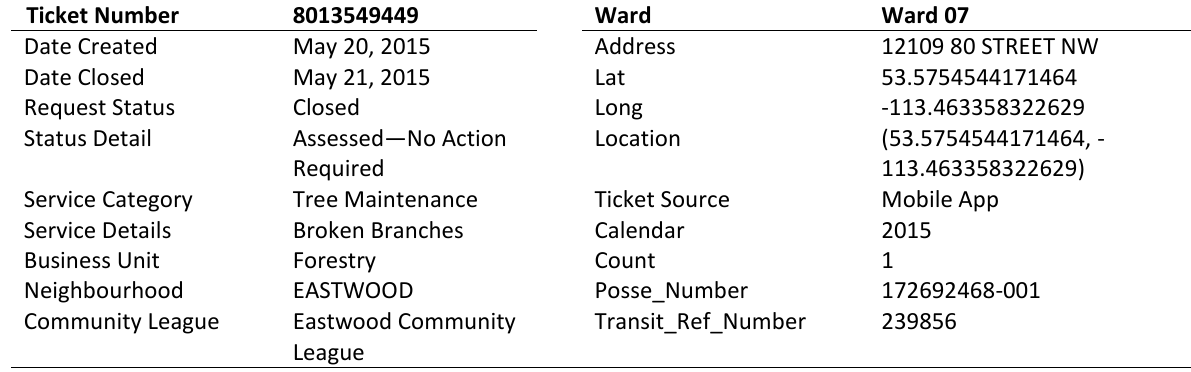
Table 1. An example of 311 request record in open data